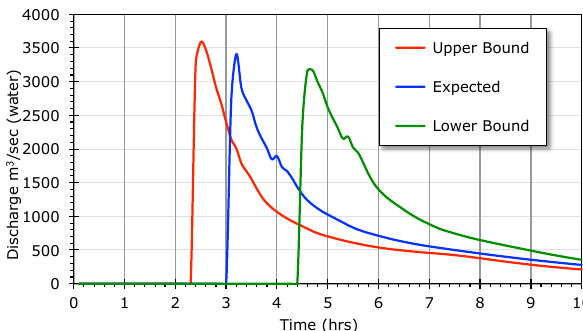
Figure 7. Upper bound, expected and lower bound GLOF hydrograph under current conditions at Phakding.